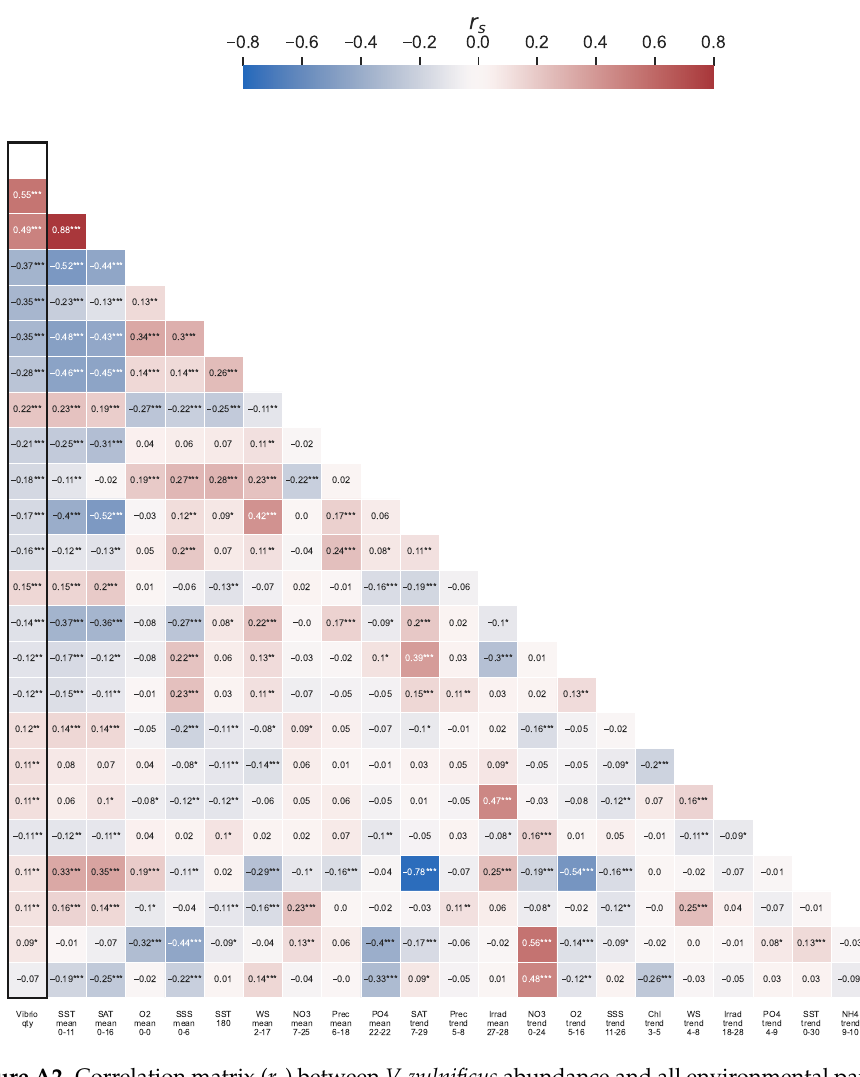
Figure A2. Correlation matrix ( r s ) between V. vulnificus abundance and all environmental parameters. Asterisks after r s indicate the significance level (*: p ≤ 0.05, **: p ≤ 0.01, ***: p ≤